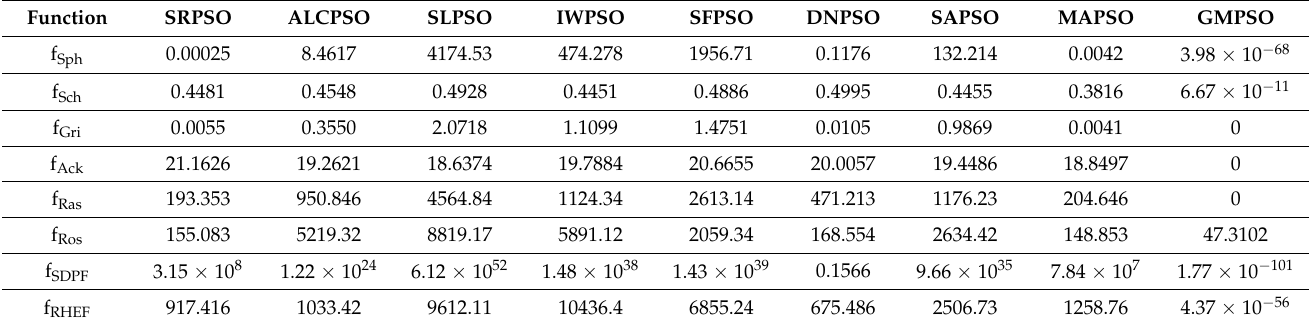
Table 2. Comparison of the optimization results of PSO variants.